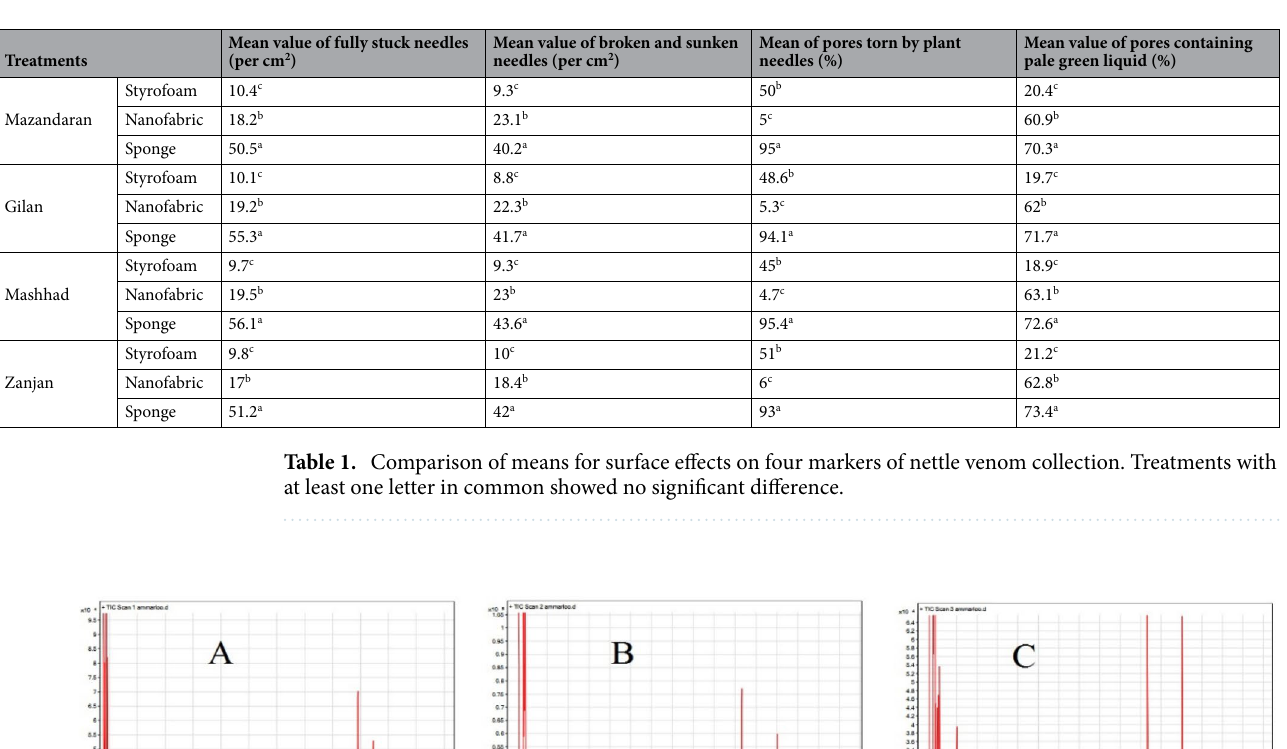
Mean value of fully stuck needles (per cm 2 )